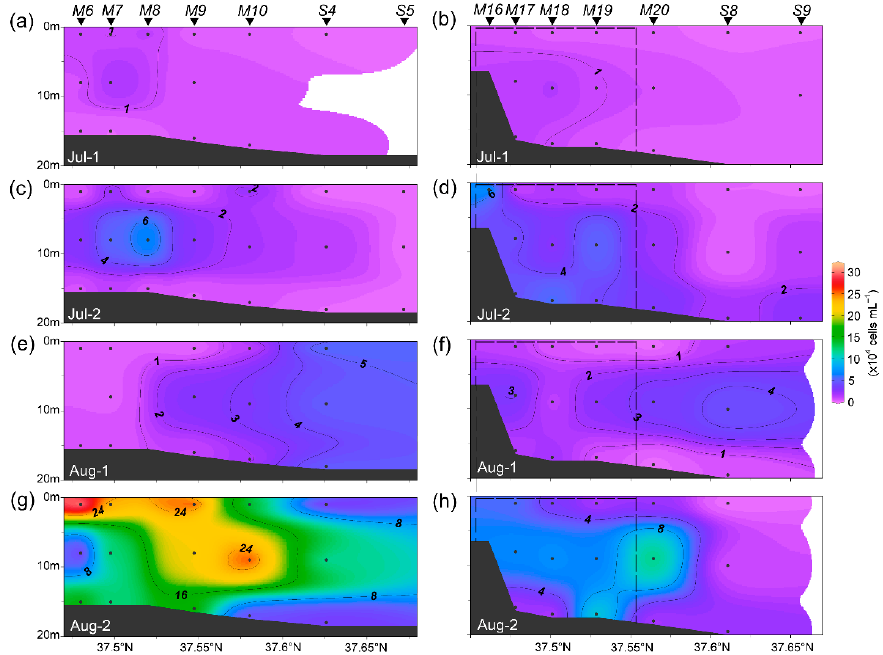
Figure 3. Vertical profiles of Synechococcus cell abundance along Transects 1 (left panel, ( a , c , e , g )) and 2 (right panel, ( b , d , f , h )) during four cruises in middle (Jun-1, ( a , b )) and late July (Jul-2, ( c , d )), and early (Aug-1, e , f ) and late August (Aug-2, ( g , h )) of 2015. Triangles along the uppermost margins indicate the positions of sampling stations. The dashed boxes refer to the location of the ranching zone ( b , d , f , h ).